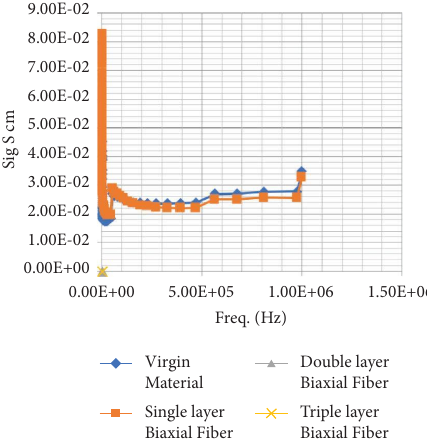
Figure 17: Comparative study of electrical